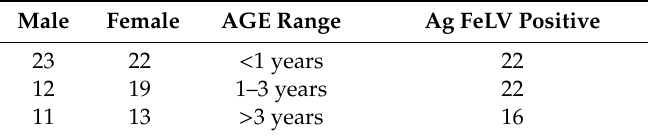
Table 1. Patients’ age ranges in terms of seropositive results.